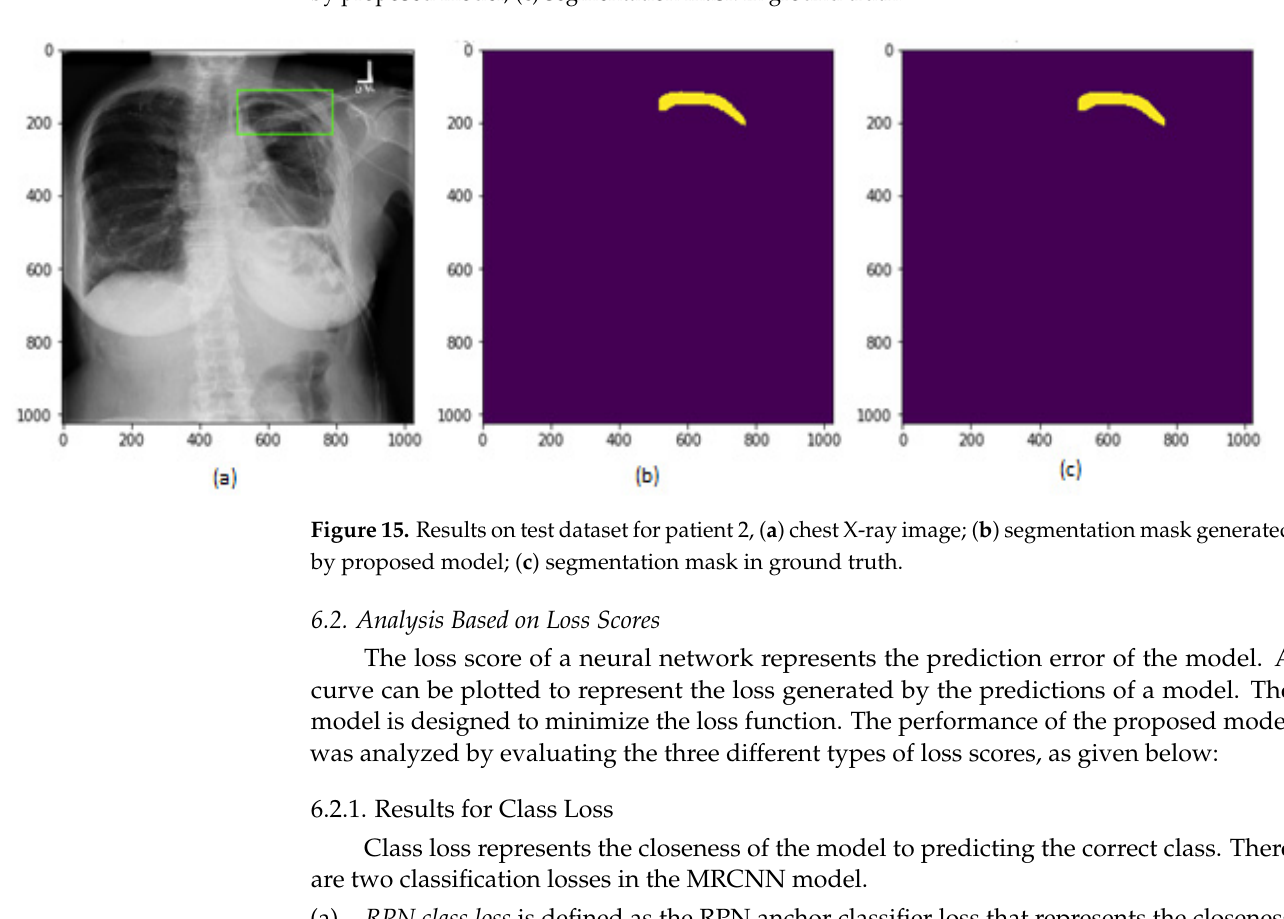
Figure 14. Results on test dataset for patient 1, ( a ) chest X-ray image; ( b ) segmentation mask generated by proposed model; ( c ) segmentation mask in ground truth.